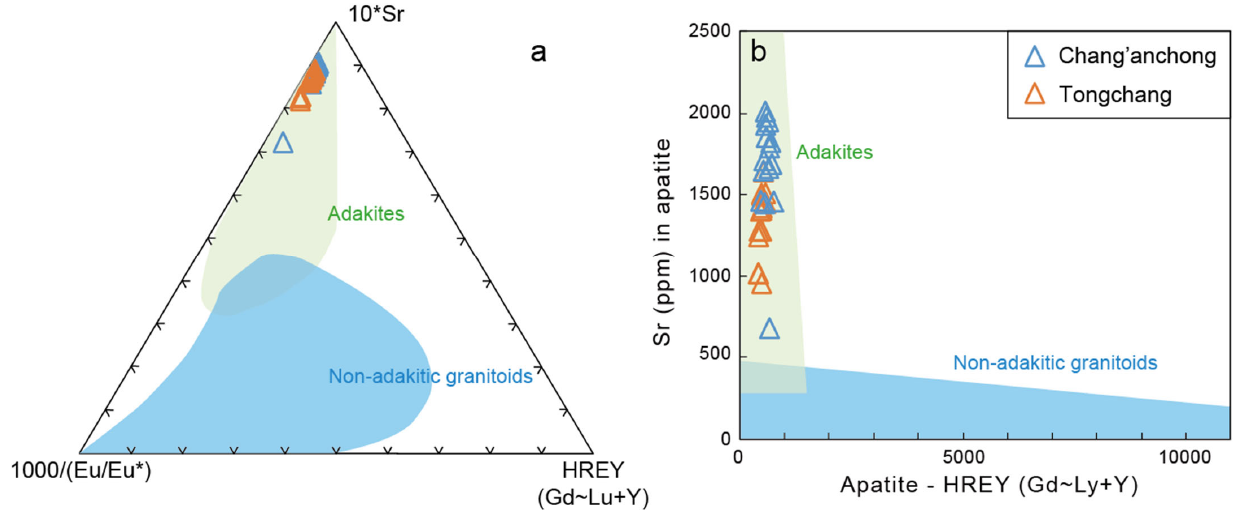
Figure 6. ( a ) Ternarydiscriminationdiagram of 1000/(Eu/Eu*)–10*Sr–HREY for apatite; ( b ) biplot of Sr vs. HREY of apatites, which shows two unique fi elds for adakites and nonadakitic granitoids [82].